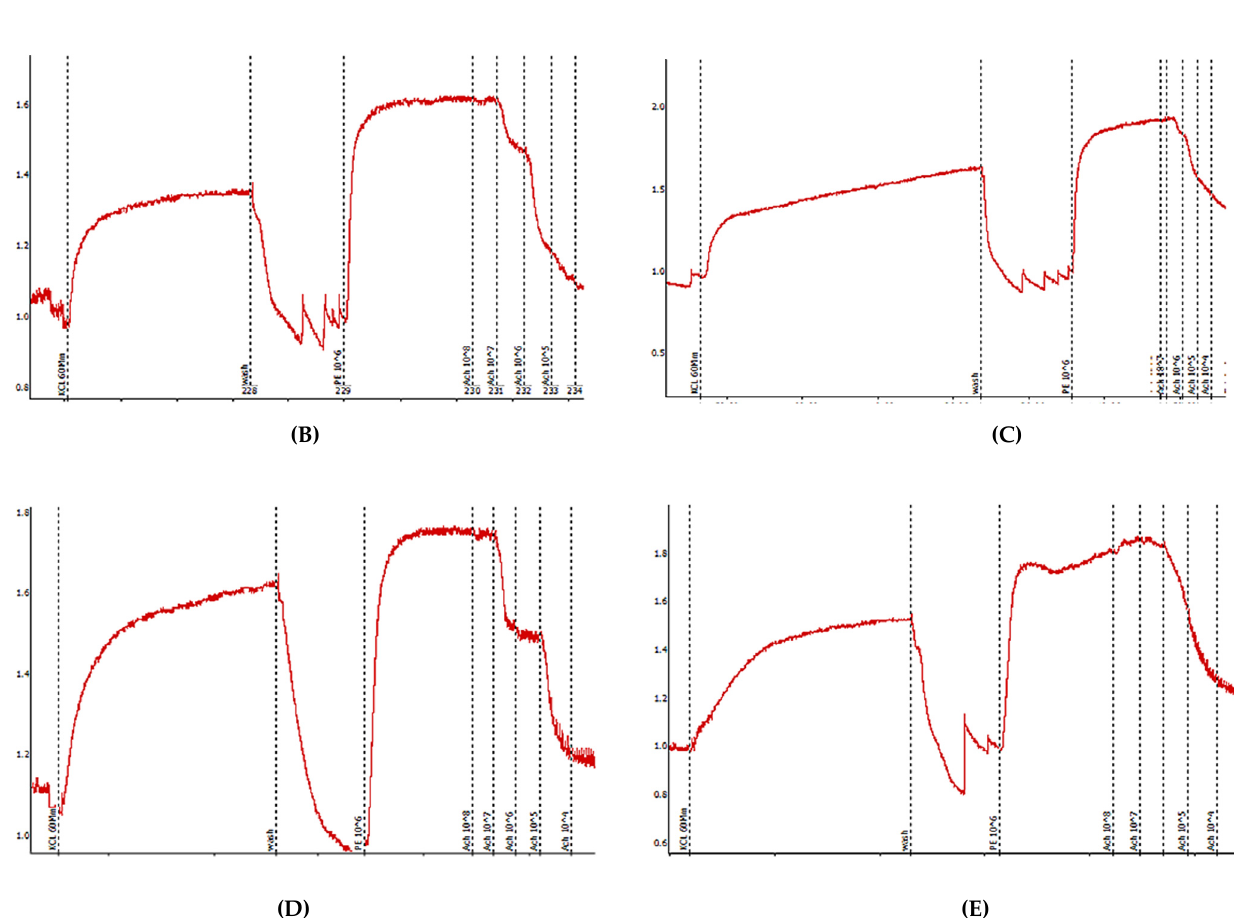
Figure 2. The vasorelaxant effect of bee bread in endothelium-intact thoracic aortic rings precontracted with phenylephrine (10 − 6 M). Fitted cumulative acetylcholine (ACh) dose–response curve is shown in ( A ), and schematic graphs of ACh-induced vasorelaxation activity from ( B ) normal, ( C ) OB, ( D ) OB/BB and ( E ) OB/OR groups are demonstrated. All values are presented as mean and standard deviation ( A ), n = 8/group. Data were analyzed using nonlinear regression. a p < 0.05 compared to normal group, b p < 0.05 compared to the OB group. OB: obese, OB/BB: obese and bee bread 0.5 g/kg/day, OB/OR: obese and orlistat 10 mg/kg/day.